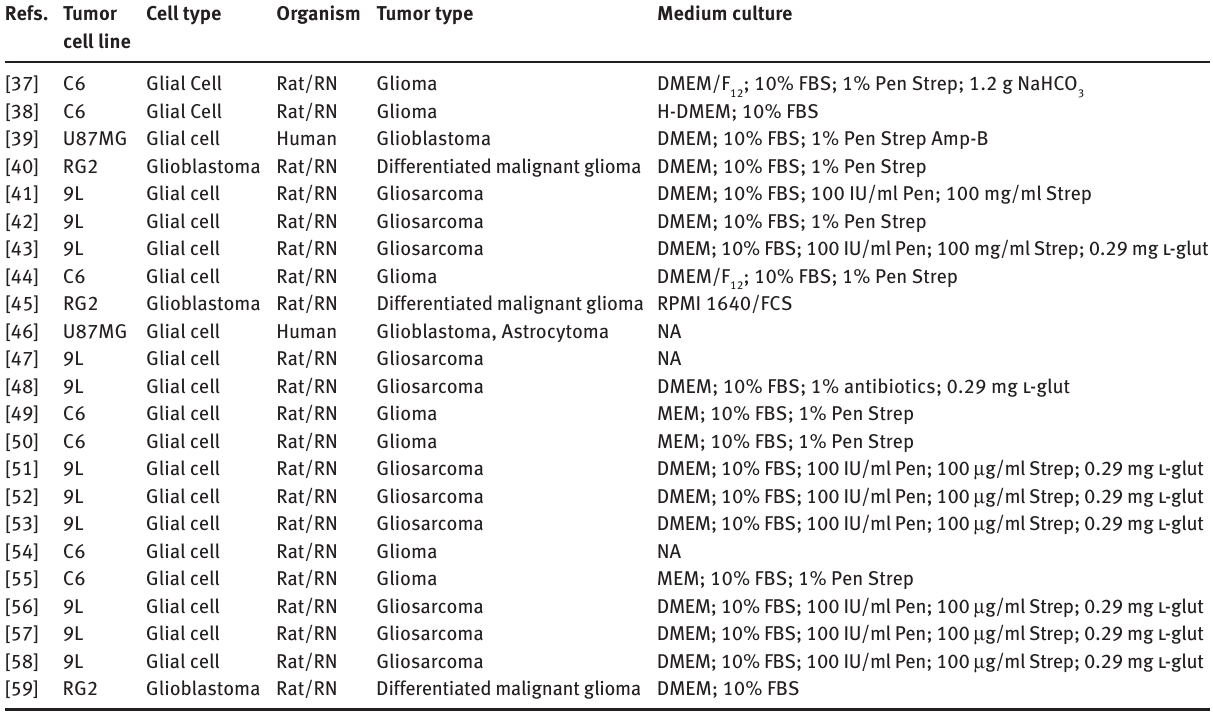
Table 2: Cell characteristics of tumor induction. Refs.